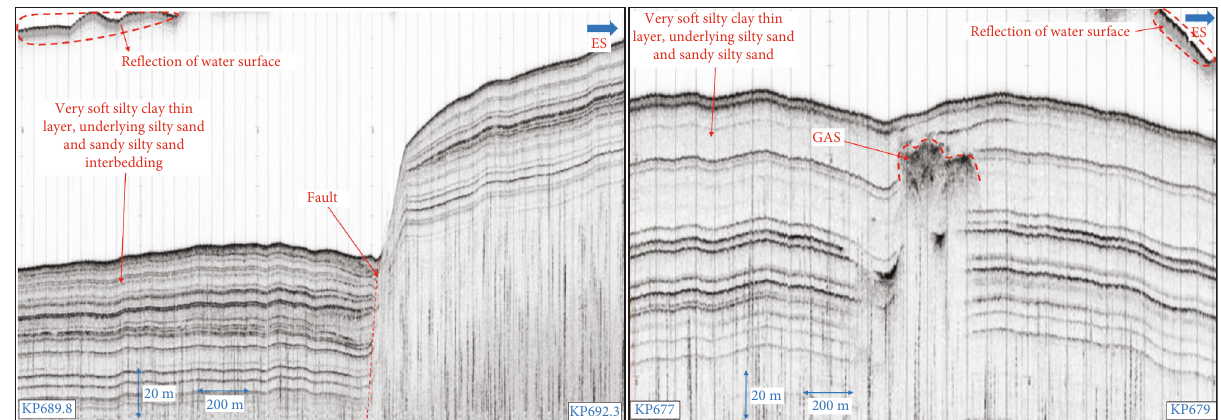
Figure 22: Pro fi le of a shallow stratigraphic of typical Okinawa Trough (left image shows the stratigraphic developed area, and the right image shows the shallow gas area).